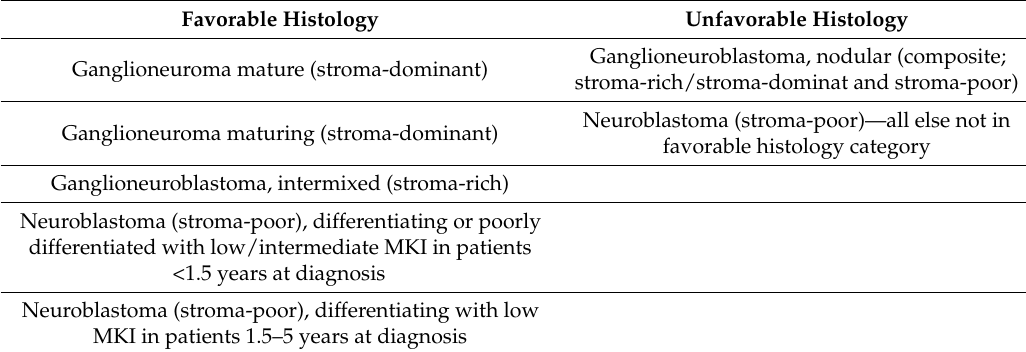
Table 3. International Neuroblastoma Pathology Classificaiton (INPC) histology